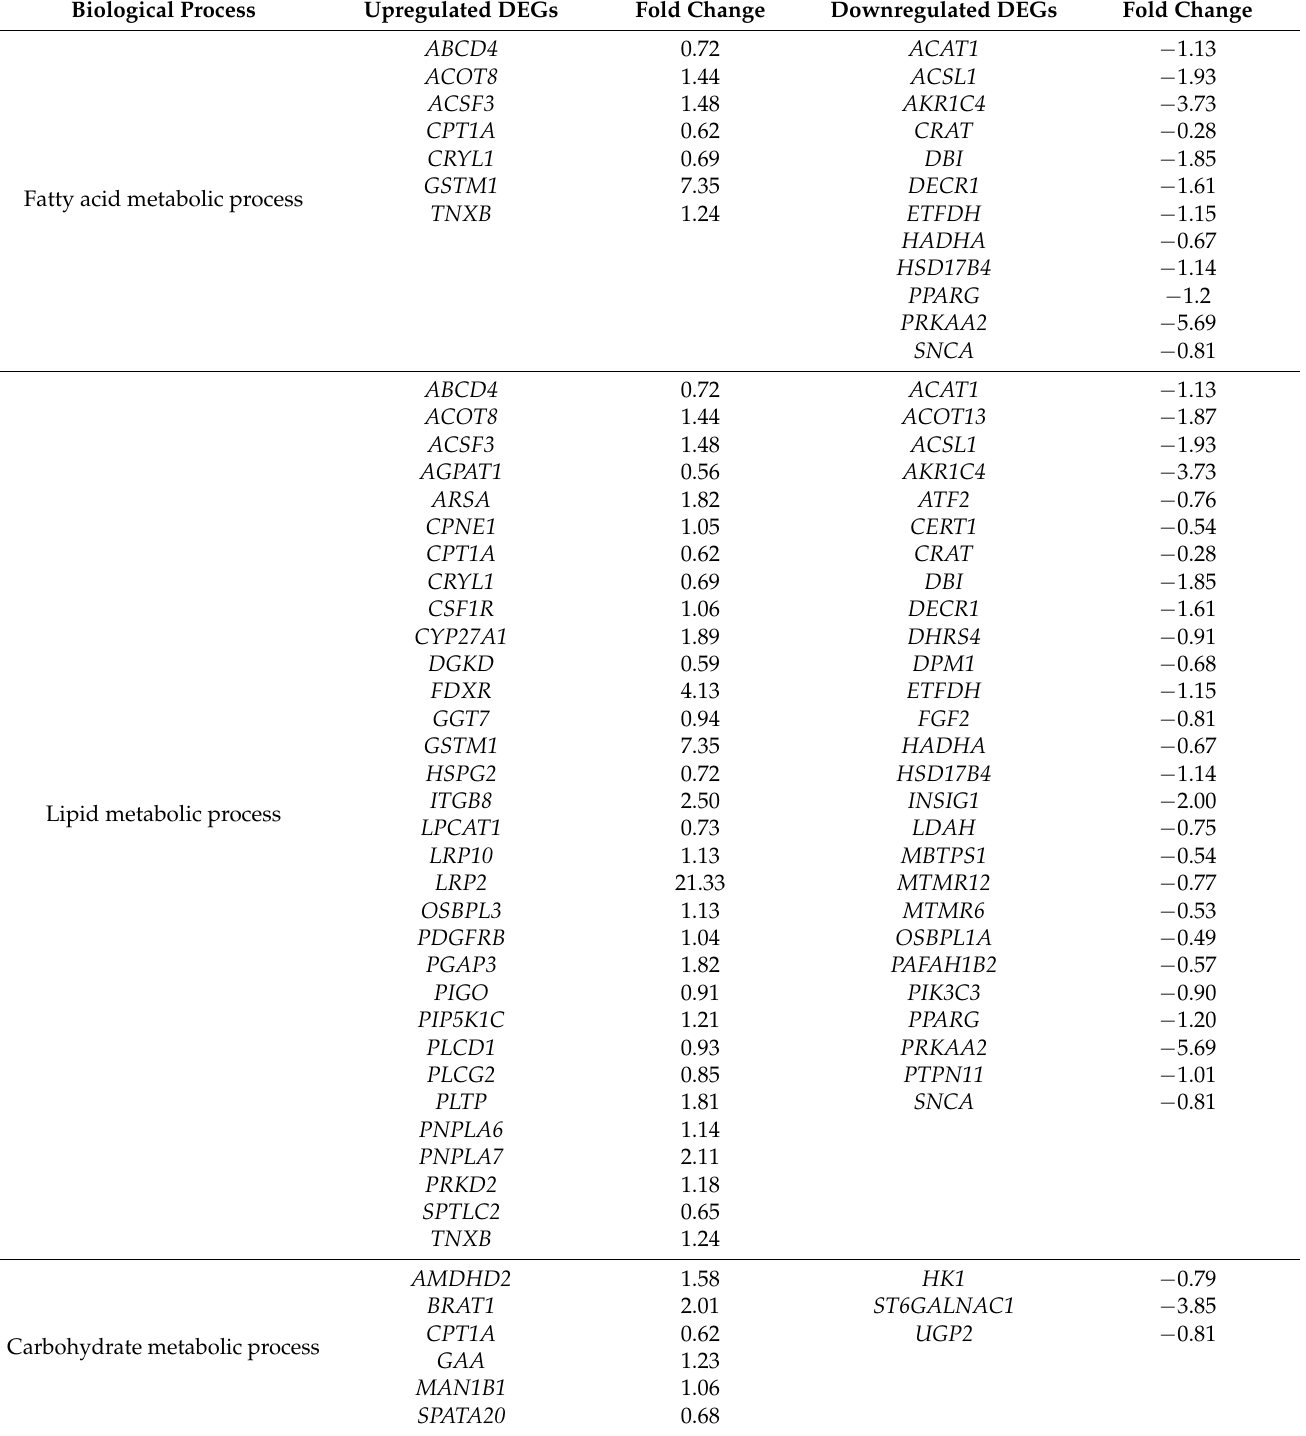
Table 2. Differentially expressed genes (DEGs) up and downregulated involved in “Fatty acid metabolic process”, “Lipid metabolic process” and “Carbohydrate metabolic